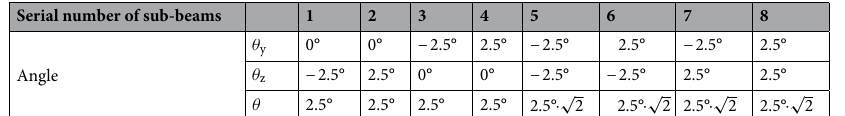
Table 1. Incident angles of the sub-beams. θ y and θ z are the rotation angles of the sub-beam around the y and z axes, respectively. We specify that, if the rotation direction of the sub-beam is clockwise, the rotation angle is positive, and vice versa. θ is the angle between the wave vector k of a sub-beam and the x -axis, θ = The incident angle of the sub beams at the corner has a multiplier factor of sqrt (2) compared to the beam at the axis due to different layout positions.